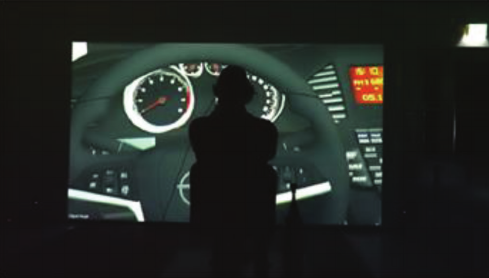
Figure 2: The VRE wall screen behind a